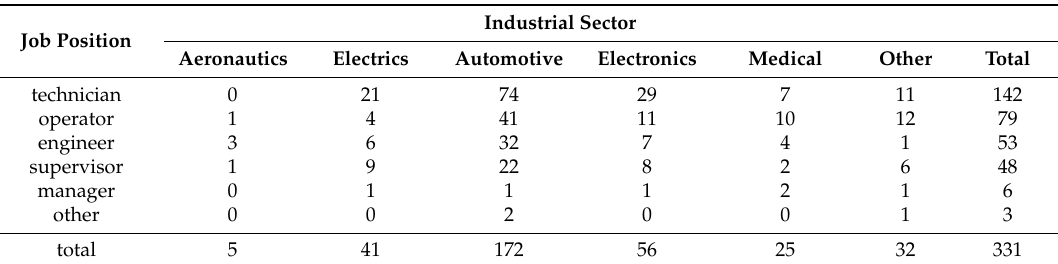
Table 3. Industrial sector vs. job